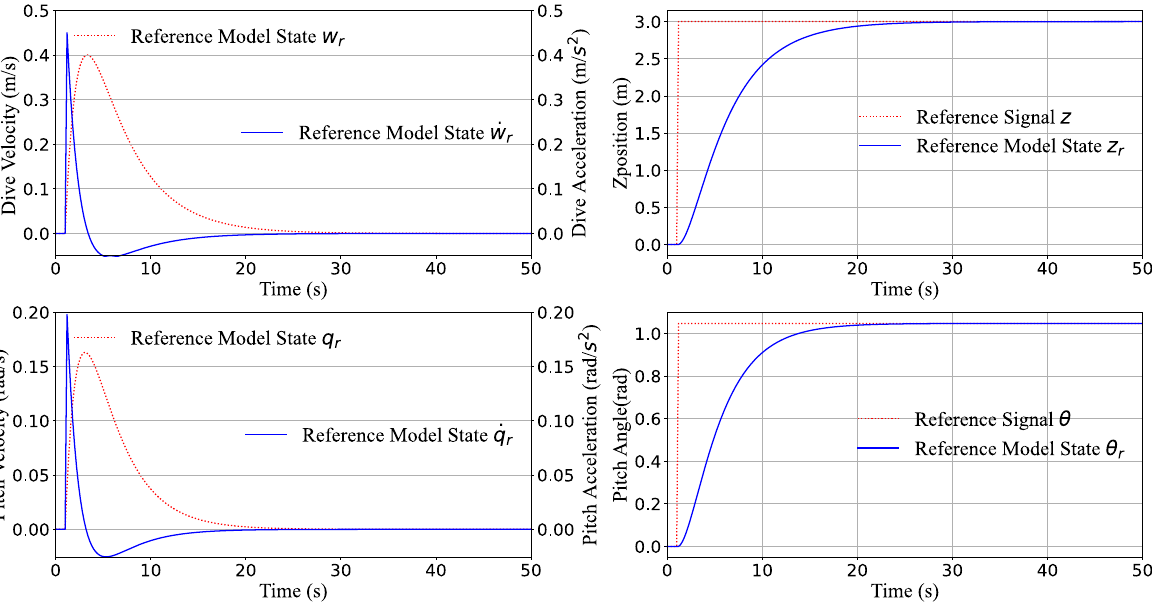
Figure 3. Depth step response of the reference model. The SI unit on the x-axis is s , and for the y-axis, the units are m/s ( left up ), rad/s ( left down ), m ( right up ) and rad ( right down ),